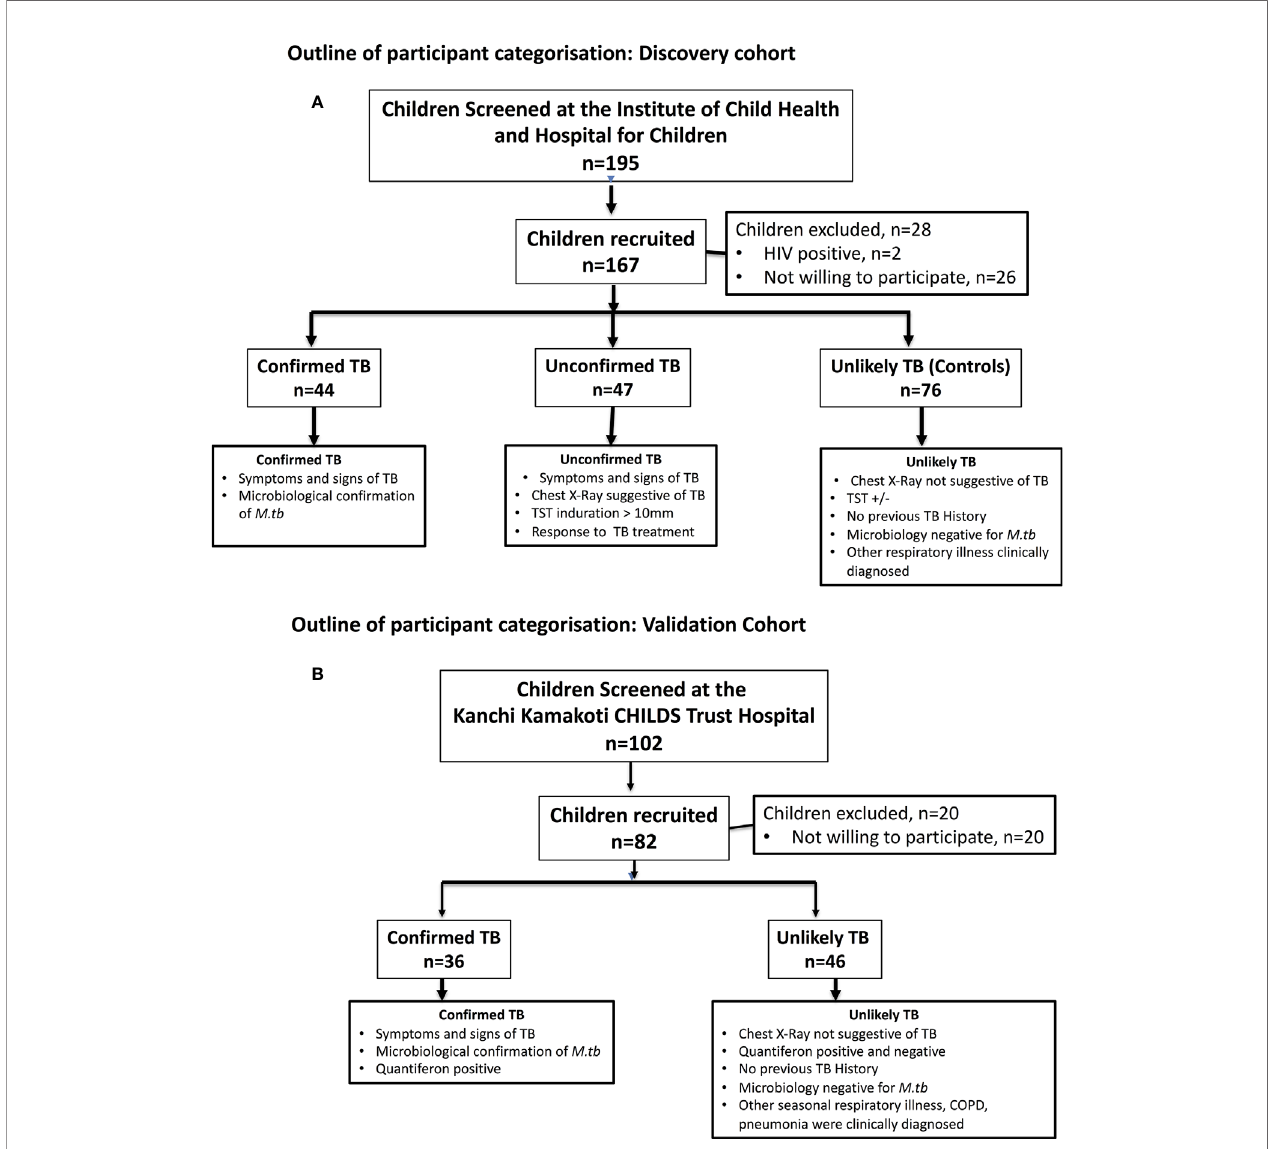
FIGURE 1 | Outline of participant categorization. (A) Discovery cohort: In the discovery cohort ( N = 167), plasma samples were collected from children who were microbiology positive (con fi rmed TB) or those negative (uncon fi rmed TB) for M.tb but with symptoms that suggested tuberculosis were studied at baseline and at the end of ATT. Children with other respiratory ailments as unlikely TB were also studied at baseline as controls. (B) Validation cohort: In the validation cohort ( N = 82), plasma samples were collected from children who were microbiology positive for M.tb with symptoms that suggested tuberculosis were classi fi ed as con fi rmed TB and children with other respiratory ailments with Quantiferon negative as unlikely TB